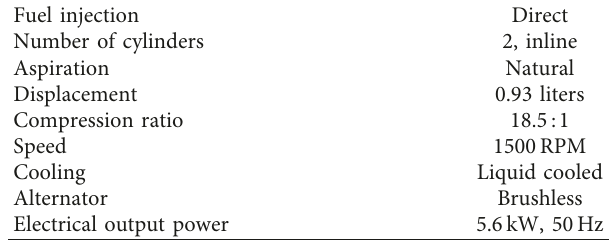
Table 4: Gas analyzer specifications. Table 3: Technical specifications of engine-generator